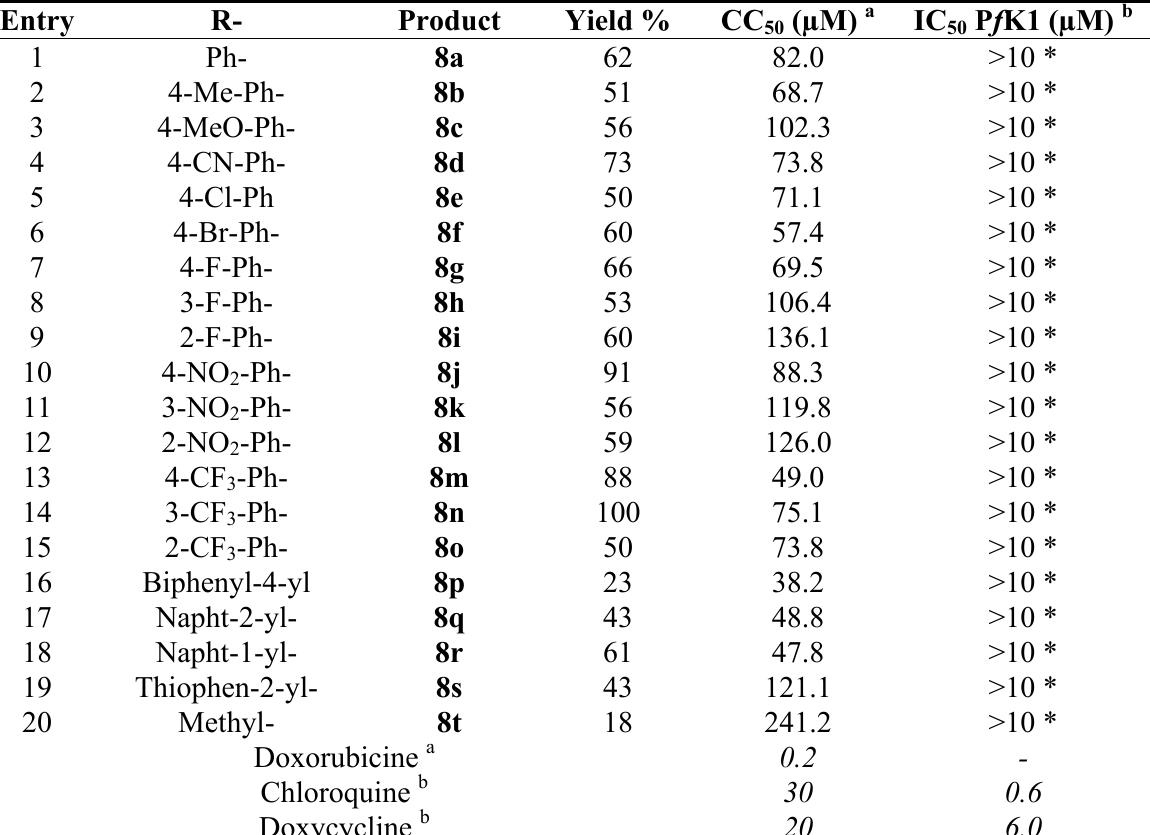
Table 1. Reaction yields and biological evaluation for sulfonamides 8a – t